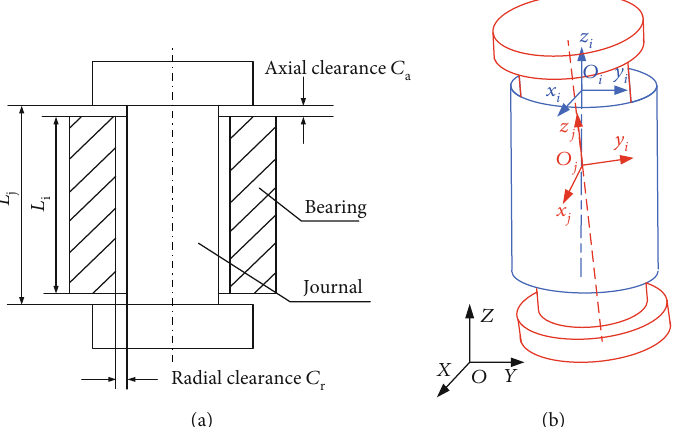
Figure 2: Con fi guration of 3D revolute joint with radial and axial clearances ((a) con fi guration of the revolute joint with clearances; (b) the geometric description for the 3D revolute